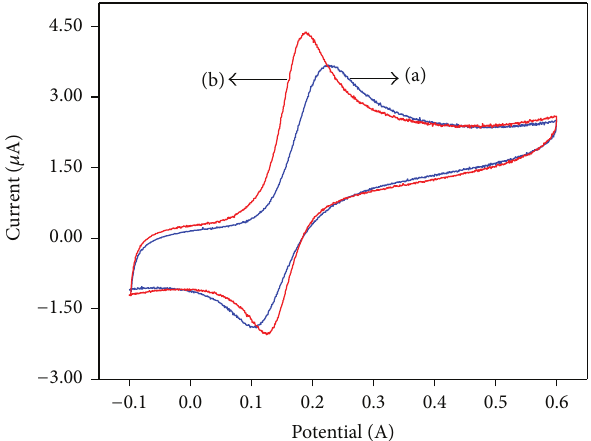
Figure 9: Cyclic voltammograms recorded at (a) bare GC and (b) 𝜇 M of DA in 0.1M PBS solution 𝛼 -Fe 2 O 3 -modified electrode for 50 (pH = 6.8) at scan rate of 50 mVs −1